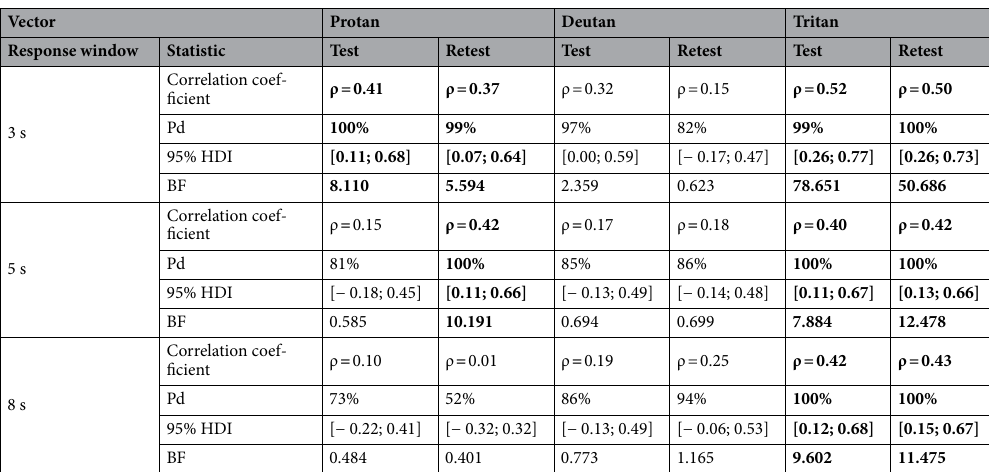
Table 3. The relationship between the vector length and age, for each response window condition, for test and retest. Presented are Bayesian correlation coefficients (ρ), Probability of direction (Pd), i.e. certainty of the effect direction, accompanied by Highest Density Intervals (95% HDI), and the Bayes Factor (BF). Correlations with Pd = 98–100%, accompanied by sufficiently high BF, are given in